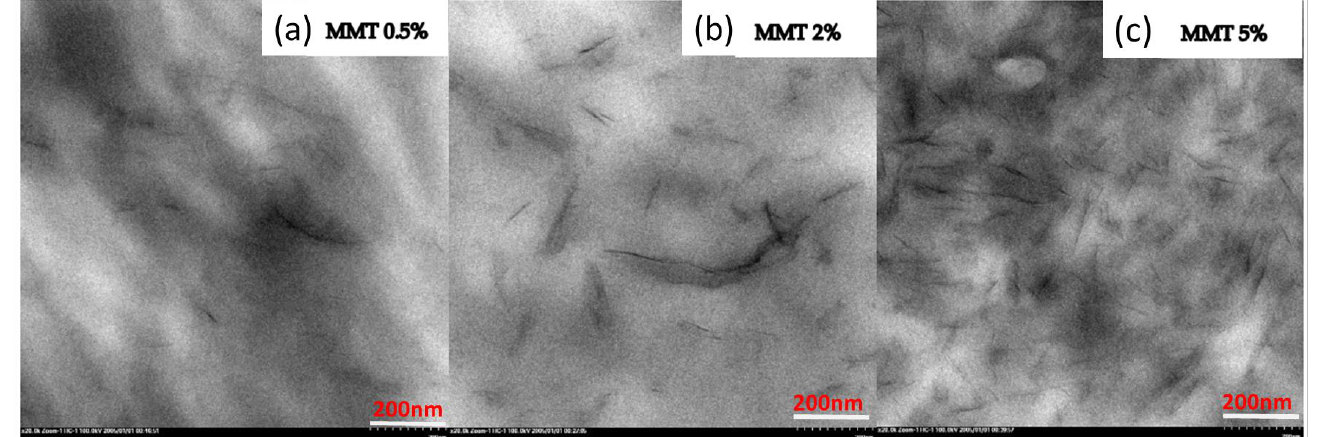
Figure 4. TEM image of nylon 6 with different MMT compositions: (a) MMT 0.5%, (b) MMT 2%, (c) MMT 5%.